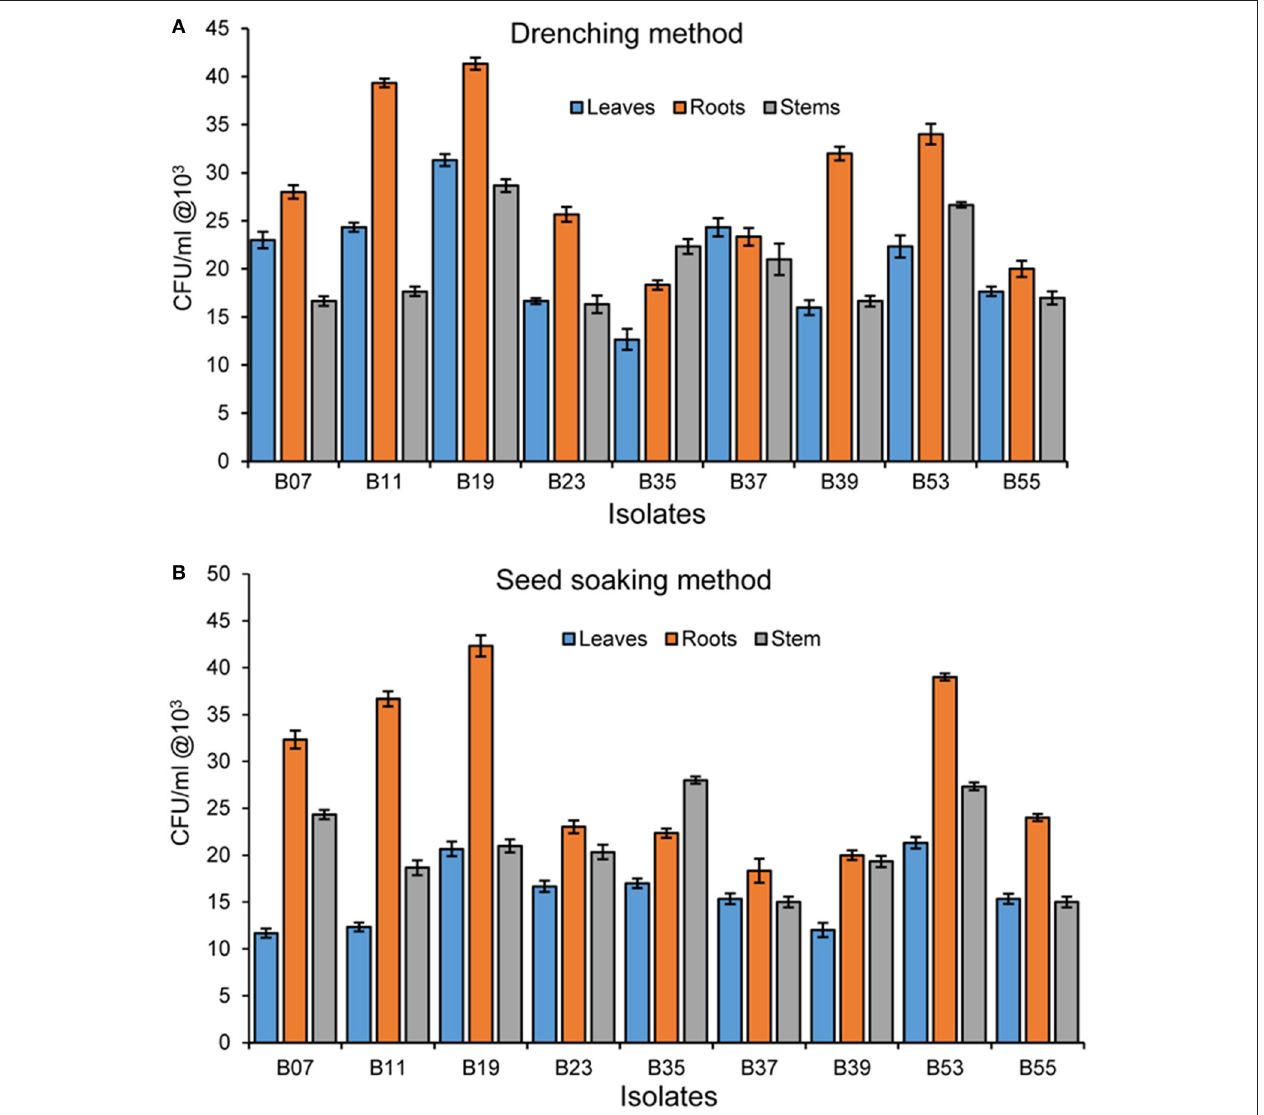
FIGURE 4 | (A) Bacterial endophyte re-isolation from different bean plant parts following inoculation using seed soaking method. (B) Bacterial endophyte re-isolation from bean plant parts following inoculation using the drenching method. Bars represent SE of the